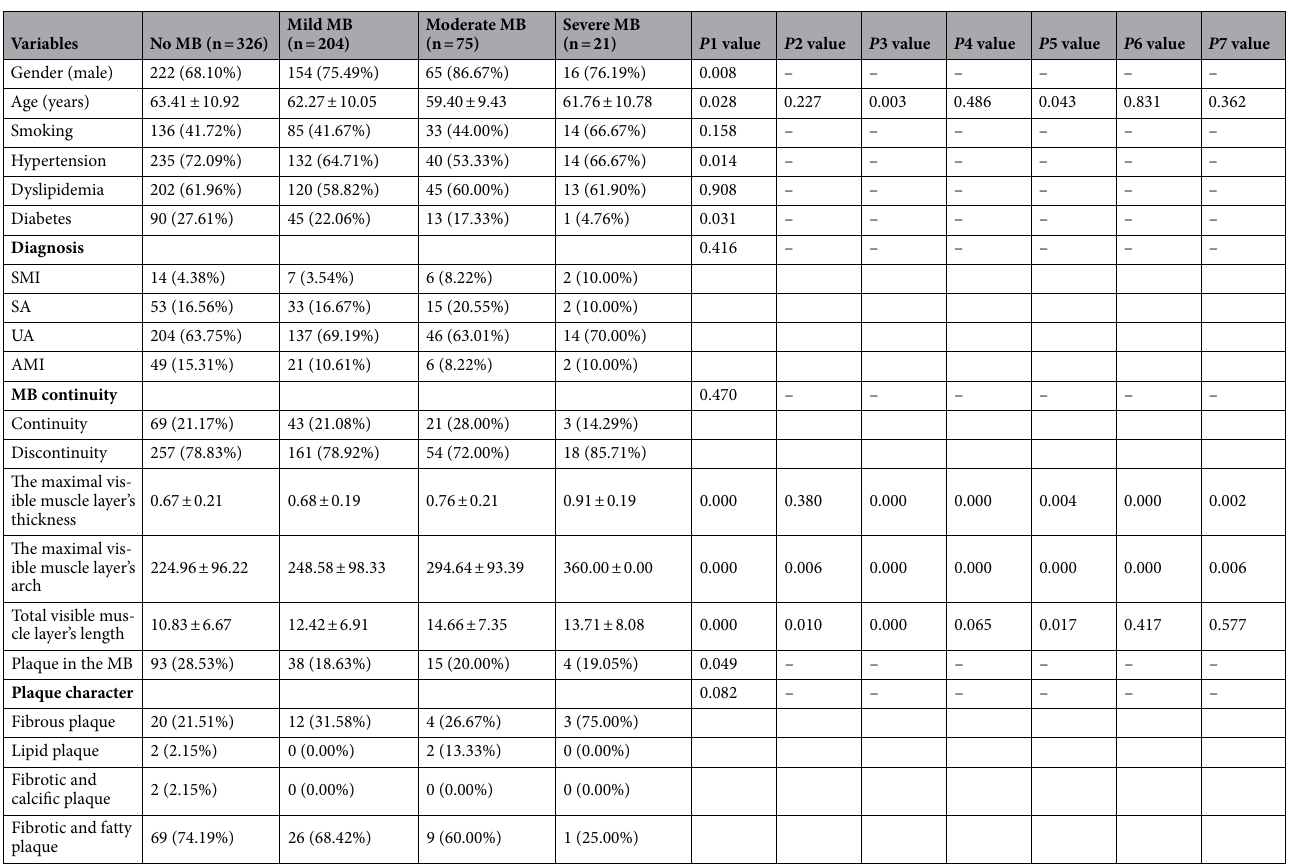
Table 4. Basic clinical and OCT characteristics among no MB, mild MB, moderate MB, and severe MB groups according to coronary angiography. Data were expressed as n (%), mean ± SD. Mild MB vs. No MB, P2; Moderate vs. No MB, P3; Severe MB vs. No MB, P4; Moderate MB vs Mild MB, P5; severe MB vs Mild MB, P6; Moderate vs. Severe MB, P7.